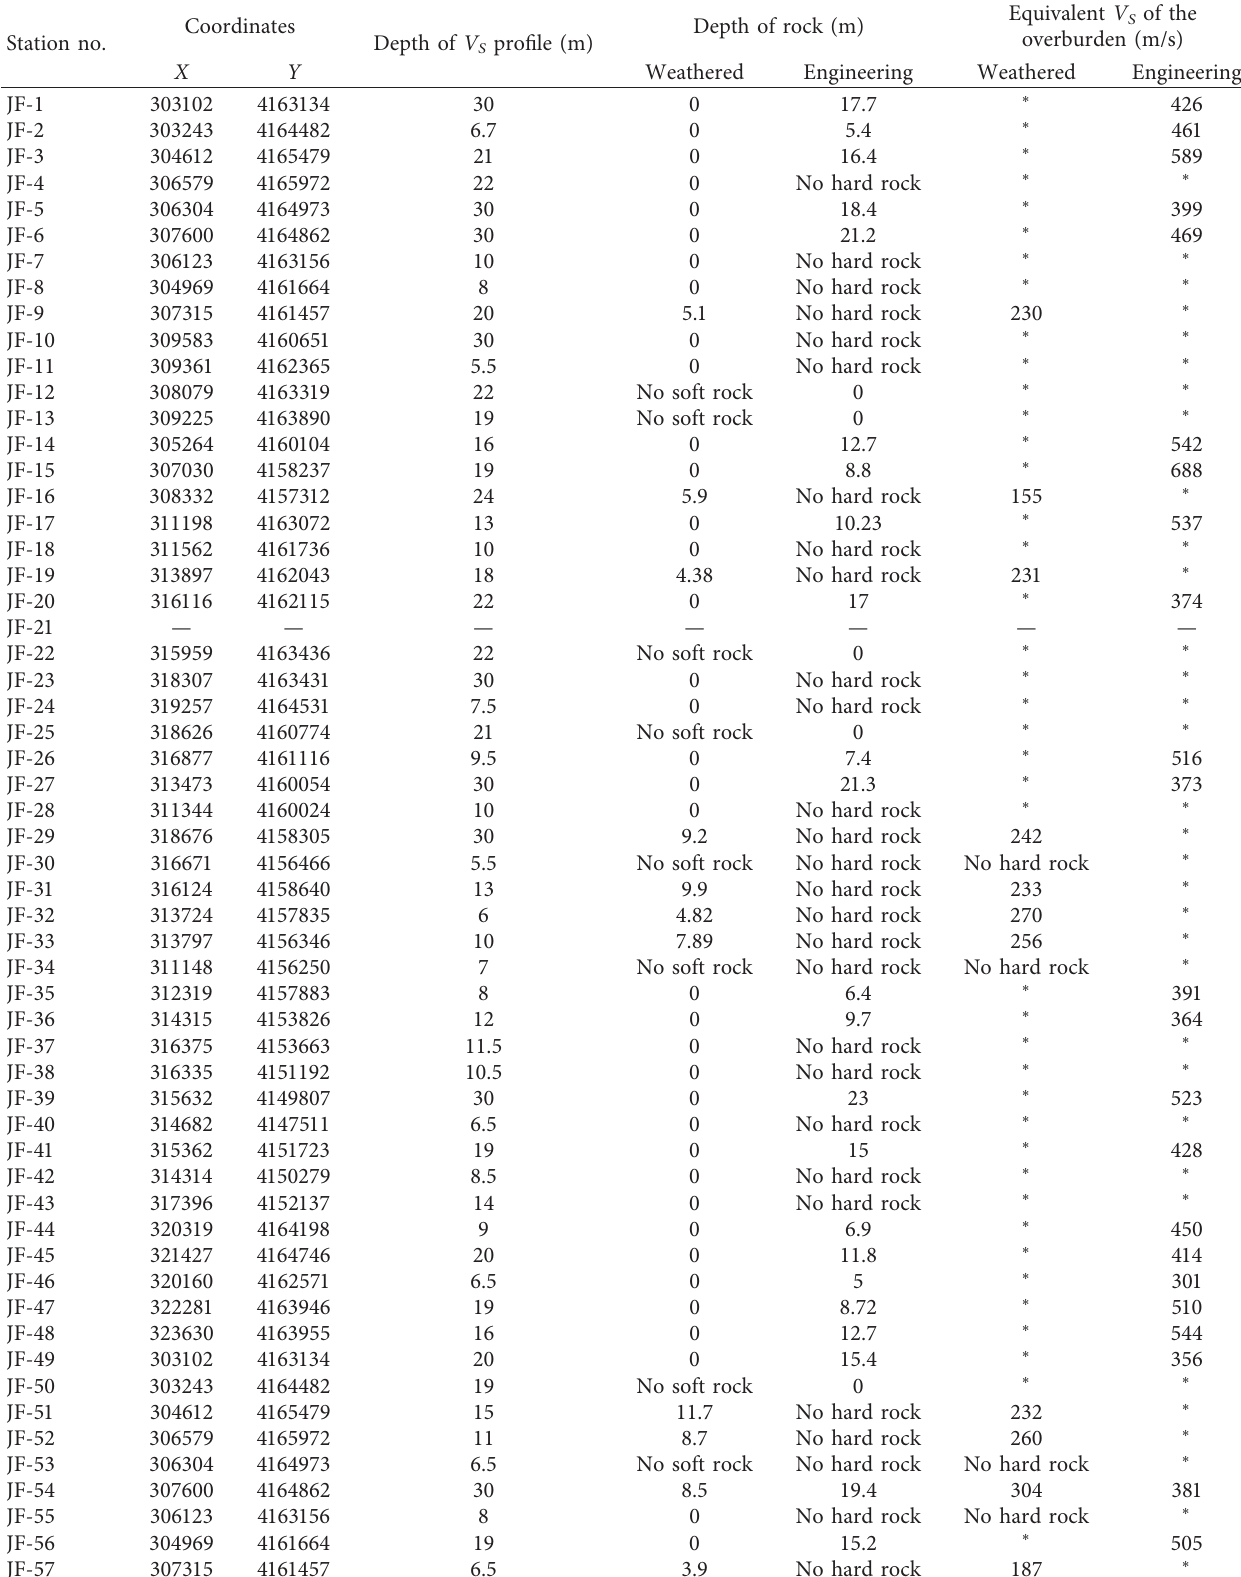
Table 3: Coordinates of MASW and MAM test stations implemented in Kahramanmaras city with depth and equivalent shear wave velocity corresponding to weathered and engineering rock. Station